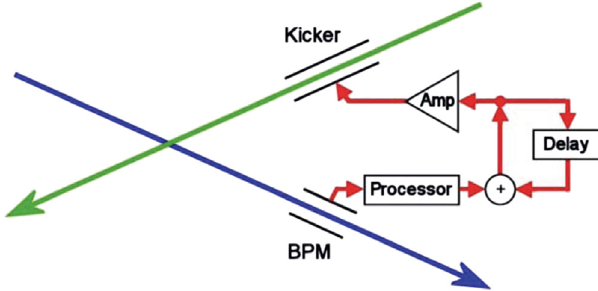
FIG. 2. Functional schematic of the intratrain IP beam feedback system [13].